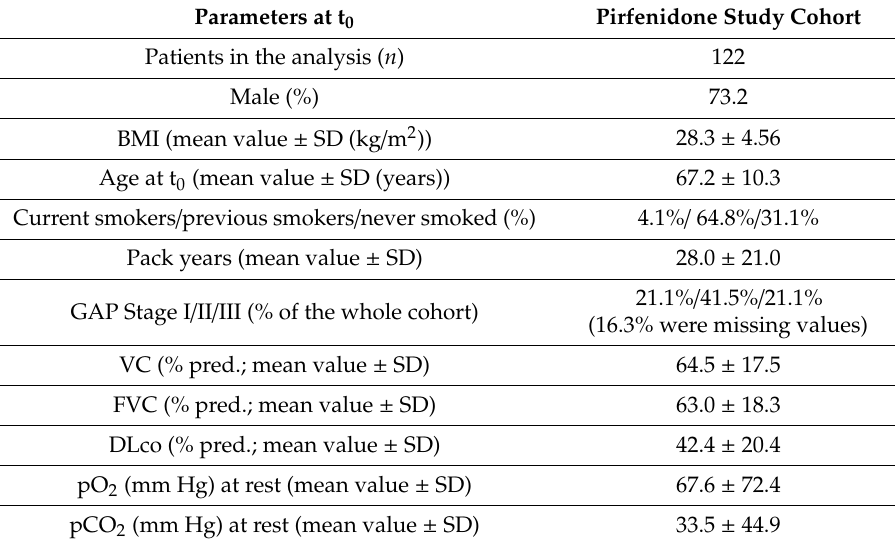
Table 1. Clinical characteristics and baseline lung function in IPF patients at t 0